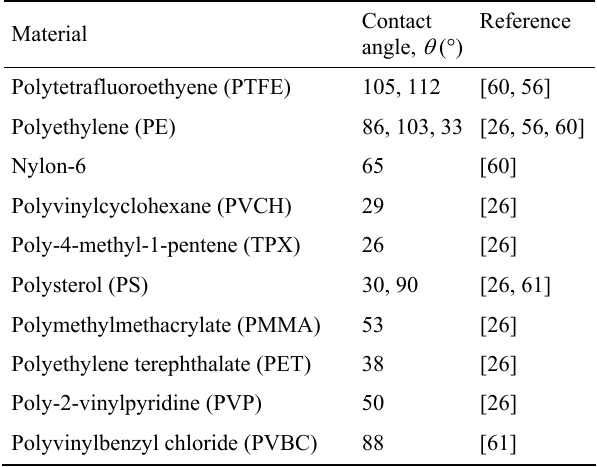
Table 1 Values of contact angle measured on polymer surface (liquid is water).